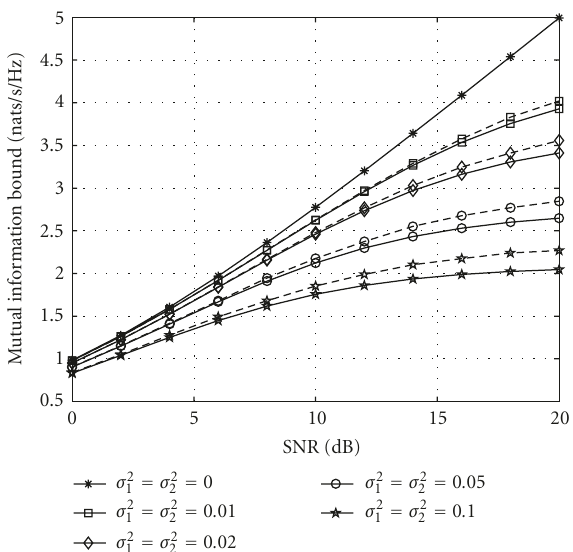
Figure 1: Mutual information lower and upper bounds for D- STBCs with single receive antenna; σ 2 1 = σ 2 2 .